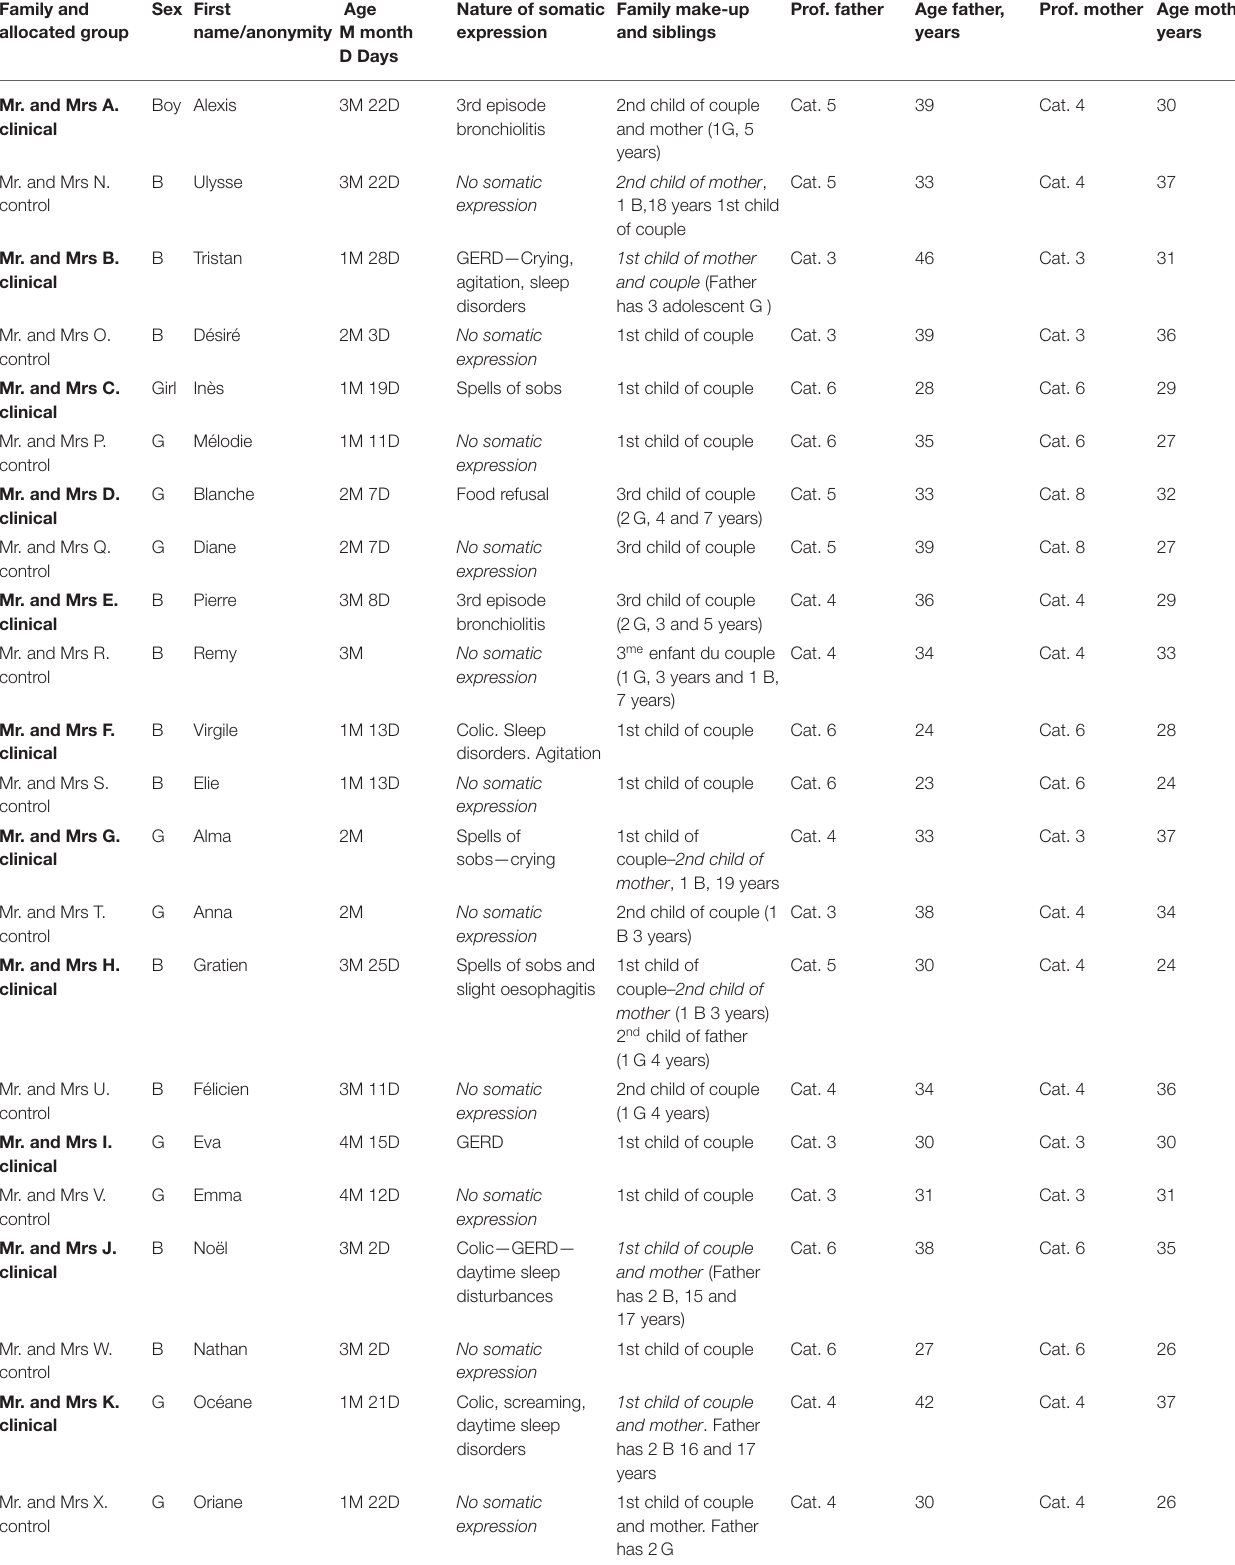
TABLE 2 | Population: children matched for sex, age, socio-professional category, and rank among siblings. Family and Sex First Age allocated group name/anonymity M